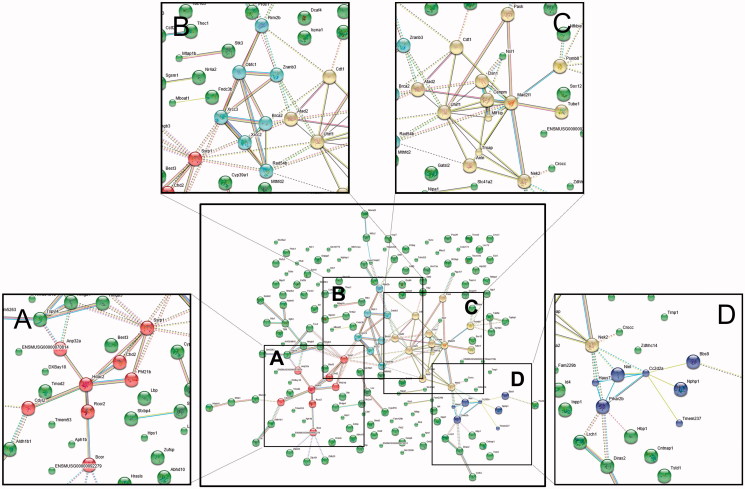
Protein network analysis using STRING data resources. Information regarding the restoration of gene expression after EHM administration in hyperlipidemic mice was uploaded to the STRING database (version 11.0) to investigate interactions between related proteins. Network nodes represent proteins, edges represent protein–protein interactions, and the line thickness indicates the strength of data support. Four main protein–protein interactions were observed, and Hdac2 (A), Xrcc2-Xrcc3 (B), Uhrf1 (C), and Prkar2b (D) were identified as key proteins in these interactions.